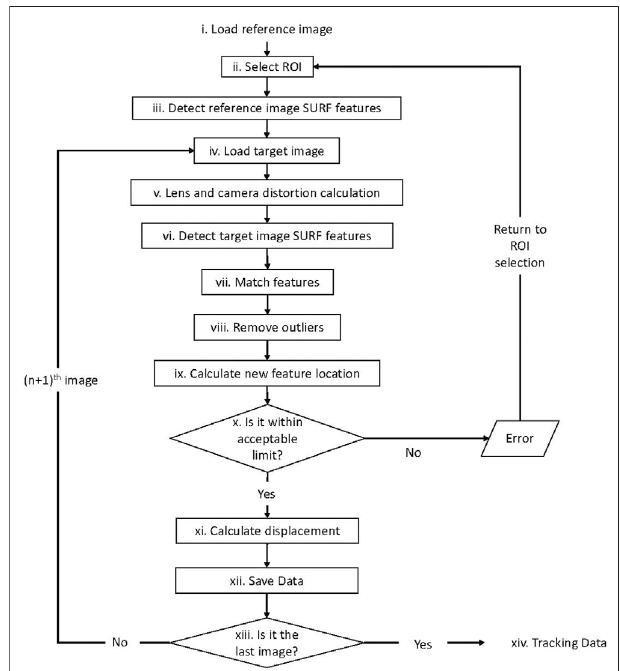
FIGURE 8 | Procedure for image-based object tracking for the OPB structure using computer